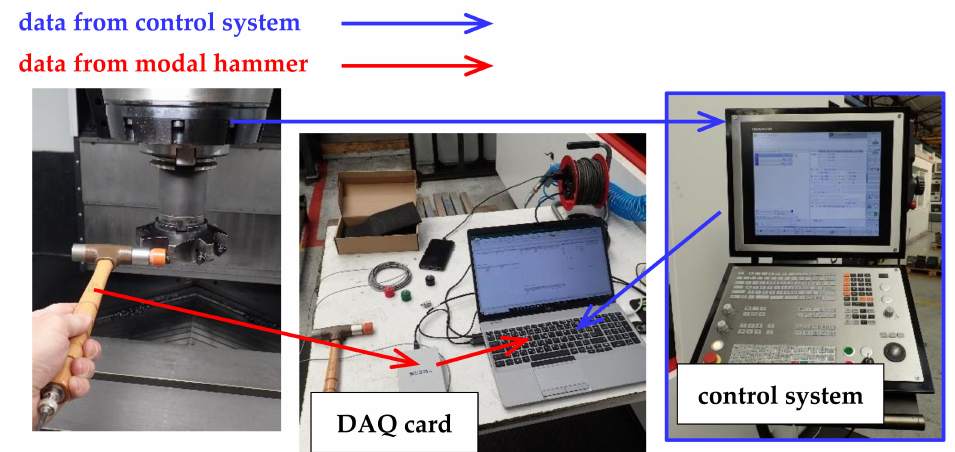
Figure 3. Measurement apparatus for calibration.